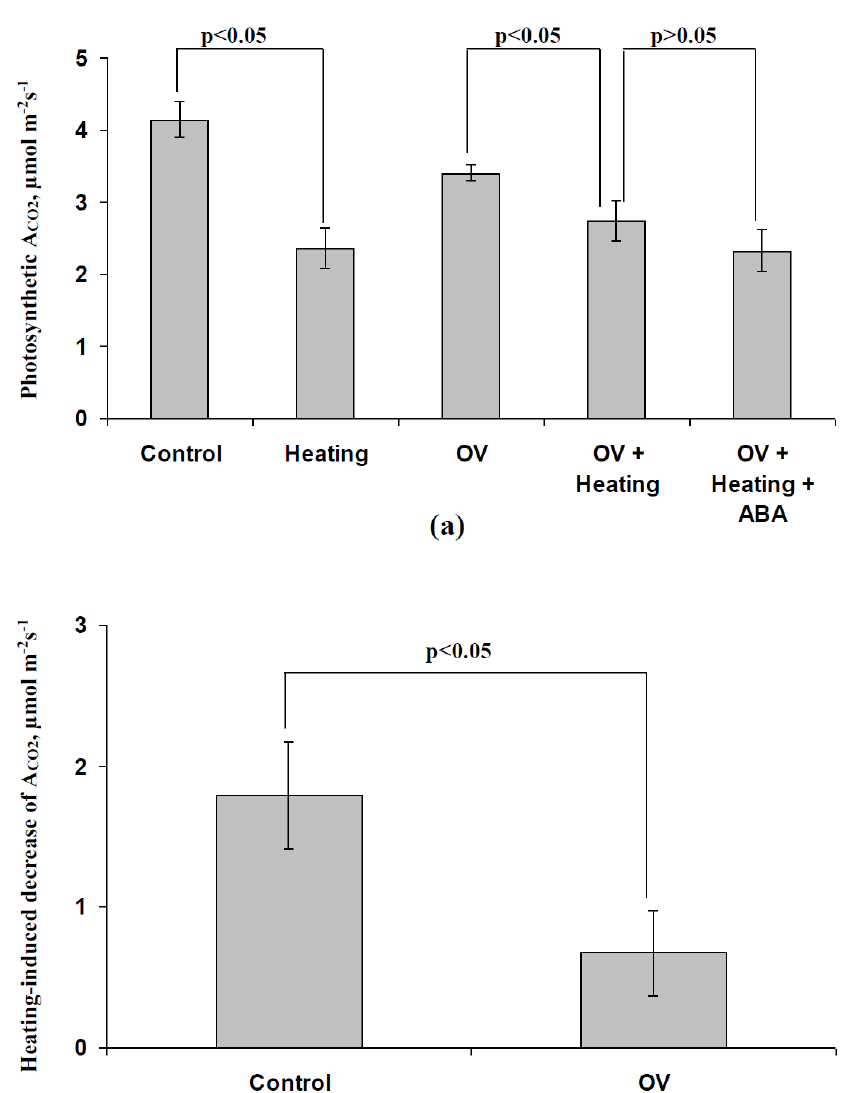
Figure 9. Influence of the modification of H + -ATP-ase activity by sodium orthovanadate (OV) on the photosynthetic heating tolerance of pea seedlings in the control group and after the ABA treatment ( n = 5-14). (a) Rates of the photosynthetic CO 2 assimilation (A CO2 ) in different variants of the experiment. (b) Heating-induced decreases in A CO2 in control and OV treatment groups. The ABA treatment of seedlings was performed by spraying them with aqueous solutions (10 −5 M) 1 day before heating; control plants were treated with equal volumes of water. The preliminary OV treatment of the leaves of seedlings was performed by incubation of the leaf (2 h) in a solution of OV with a moderate concentration (0.5 mM); after that, this leaf was dried by filter paper and seedlings were heated. Similar treatment by water was used in the control. Seedlings were heated from 23–24 °C to 48 °C for 30 min using a thermostat. The photosynthetic CO 2 assimilation was measured after 10 min of illumination by blue actinic light (239 µmol m −2 s −1 ); photosynthetic measurements were performed 1 day after heating in the second mature leaf.